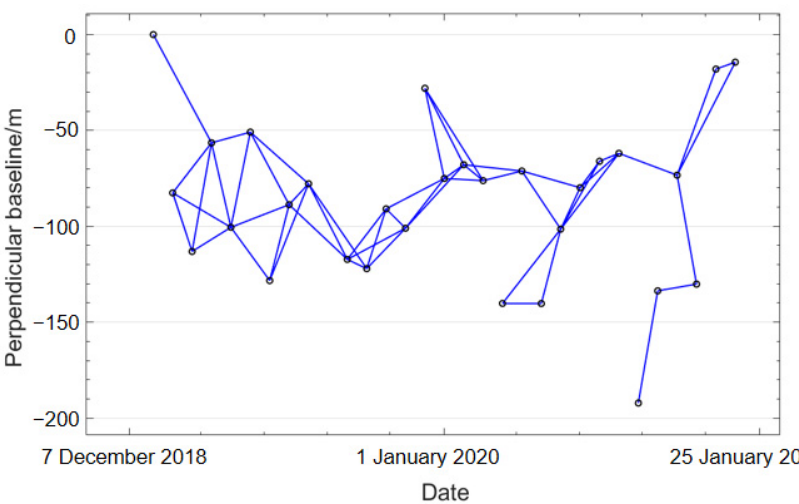
Figure 3. Spatial and temporal baseline combination of SAR images.